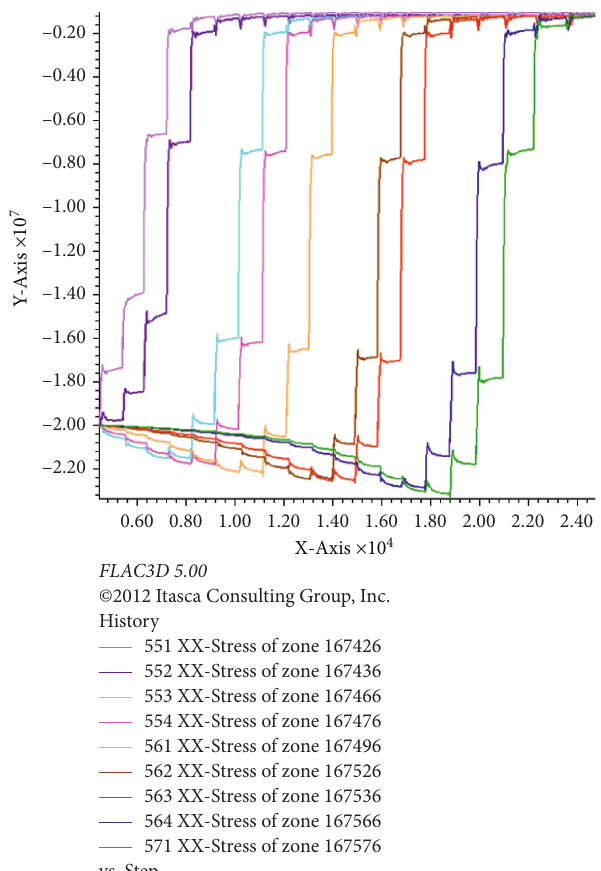
Figure 12: Horizontal stress variation curve of two sides of